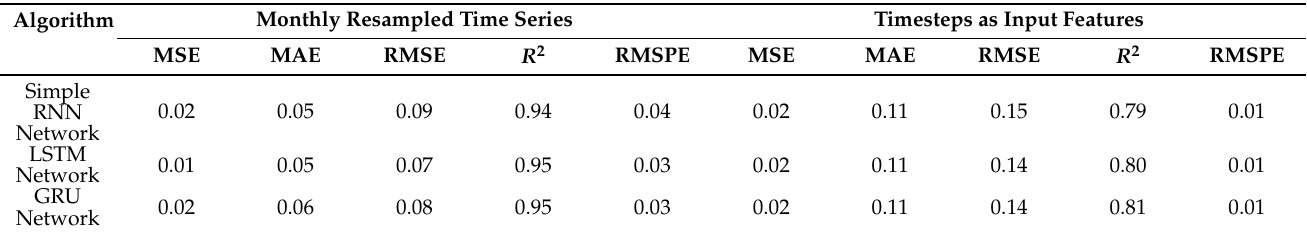
Figure 12. Comparison of feature selection methods’ performance when predicting future visual acuity from all OCT data. Average cross-validated R 2 scores for all neural networks were computed. Table 10. Results when forecasting from all OCT data (including fundus image embeddings), from one previous visit.